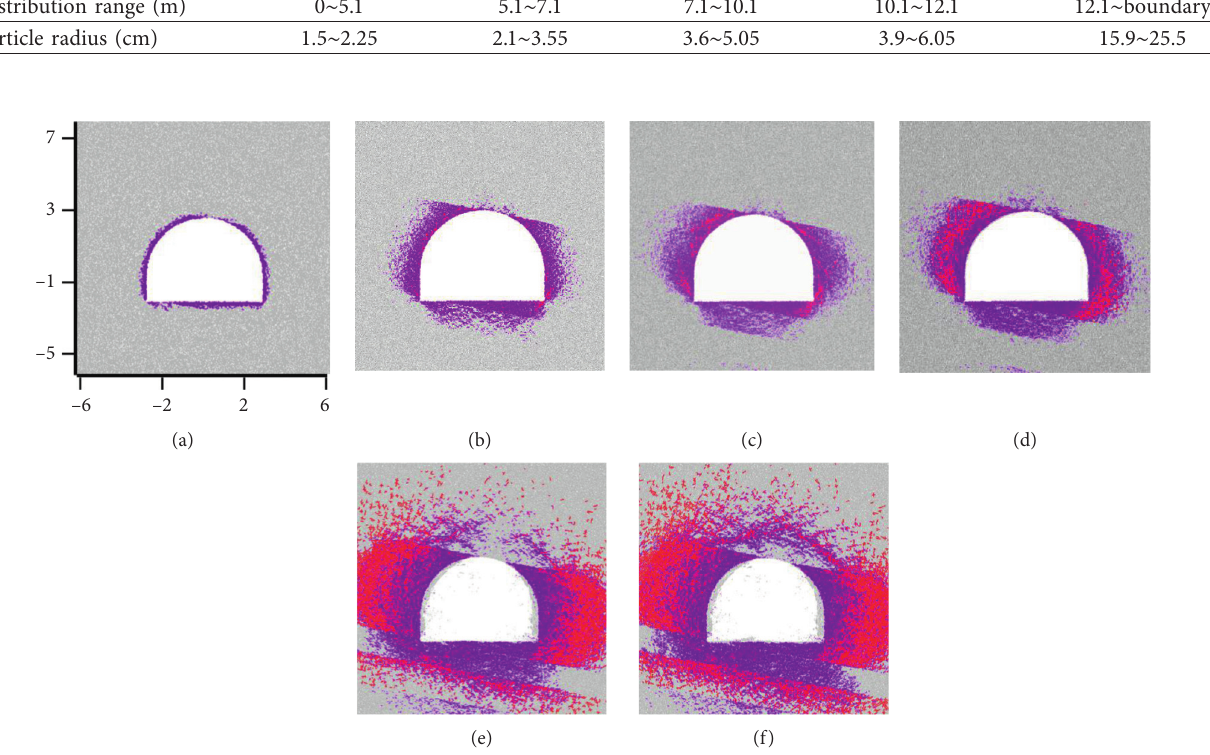
Figure 21: The fracture distribution during roadway excavation and longwall retreatment.